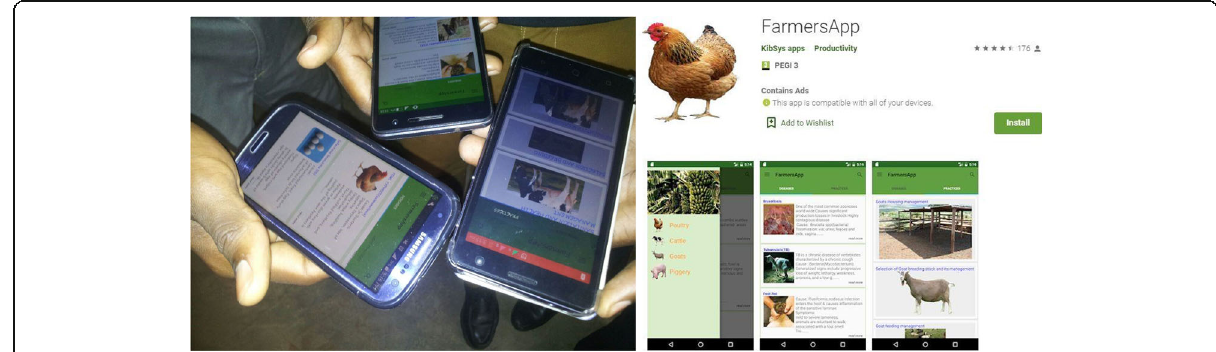
Fig. 3 Student demonstrating the Farmers App (left) and the different views of the app (right)